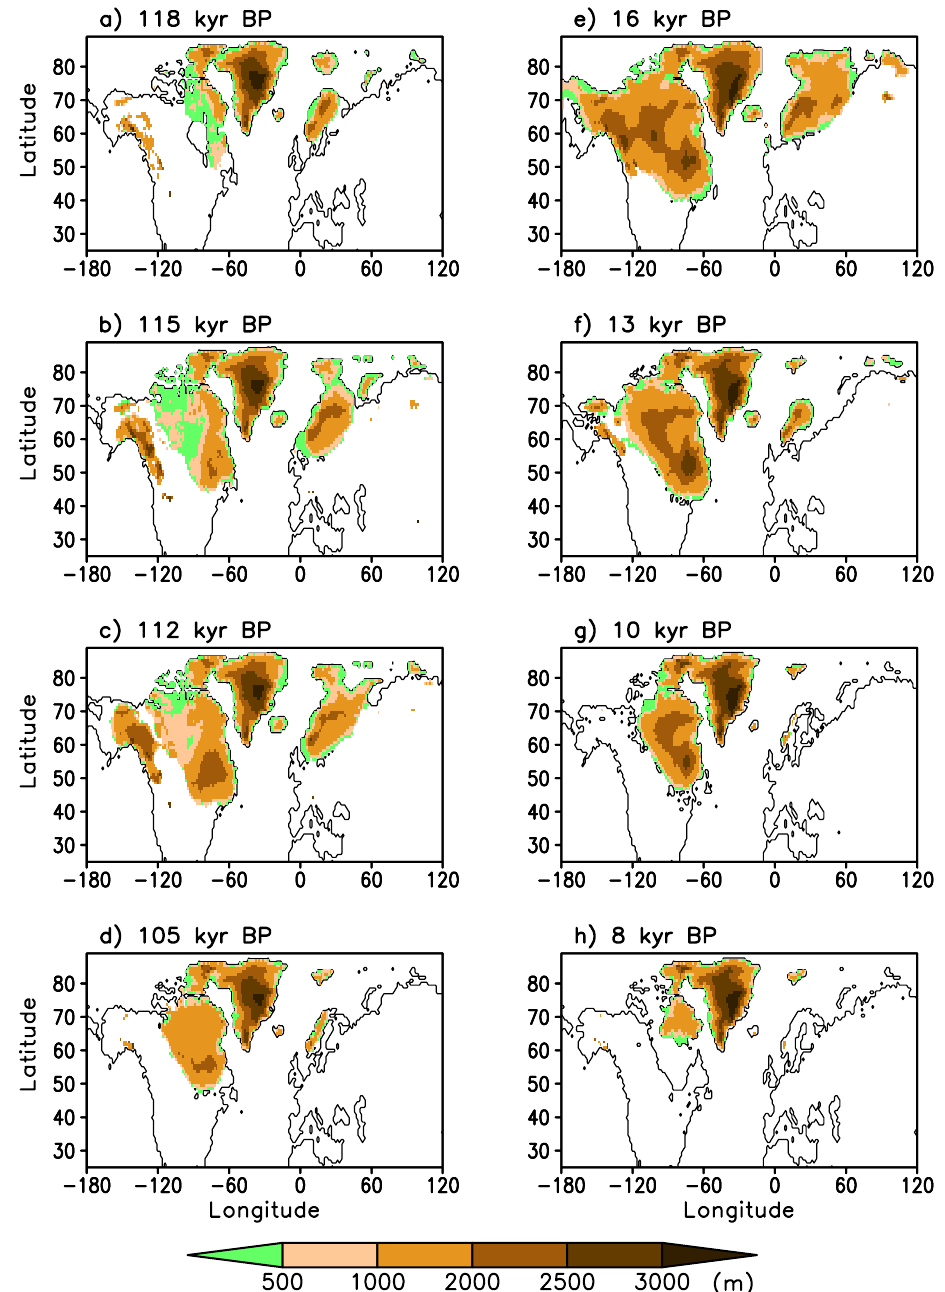
Fig. 4. Spatial extent and elevation of simulated ice sheets at different time slices during MIS 5: (a) 118kyrBP, (b) 115kyrBP, (c) 112kyrBP, (d) 105kyrBP, and during last glacial termination: (e) 16kyrBP, (f) 13kyrBP, (g) 10kyrBP, (h)